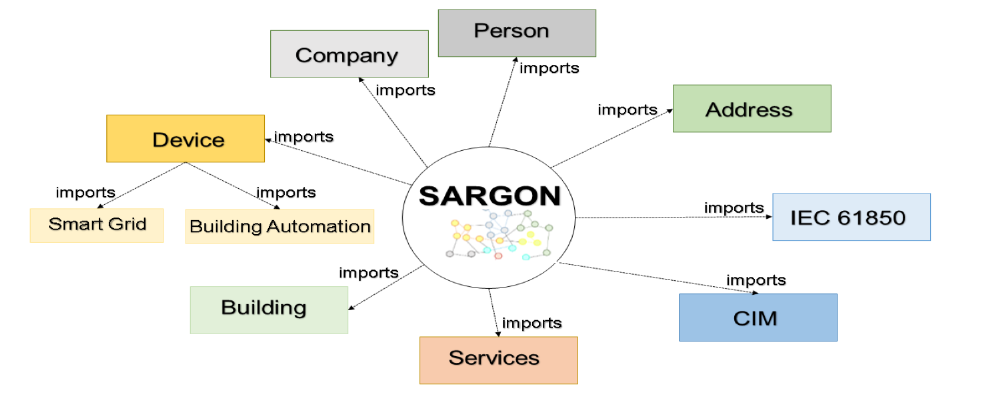
Figure 2. SARGON ontology network